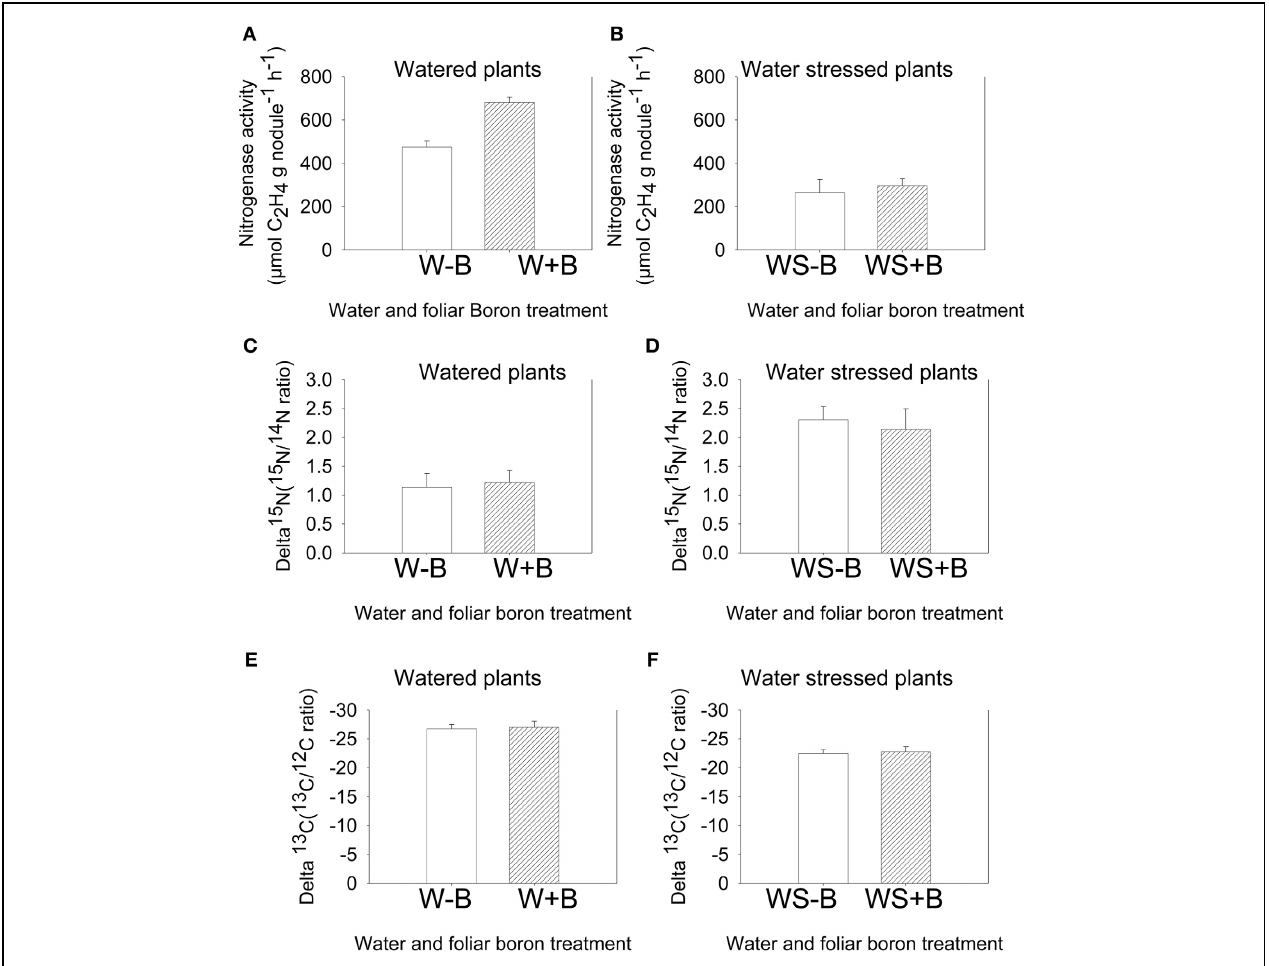
watered plants (E) and water stressed plants (F). Treatments were watered plants without foliar B (W–B), and watered plants with foliar B (W + B), water stressed plants with no foliar B (WS–B); water stressed plants with foliar B (WS +